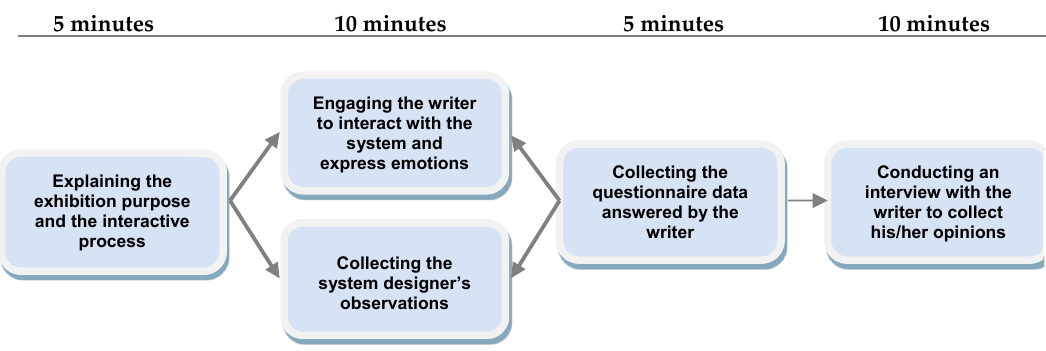
Figure 8. Procedure of the activities conducted in the public exhibition of the proposed system.